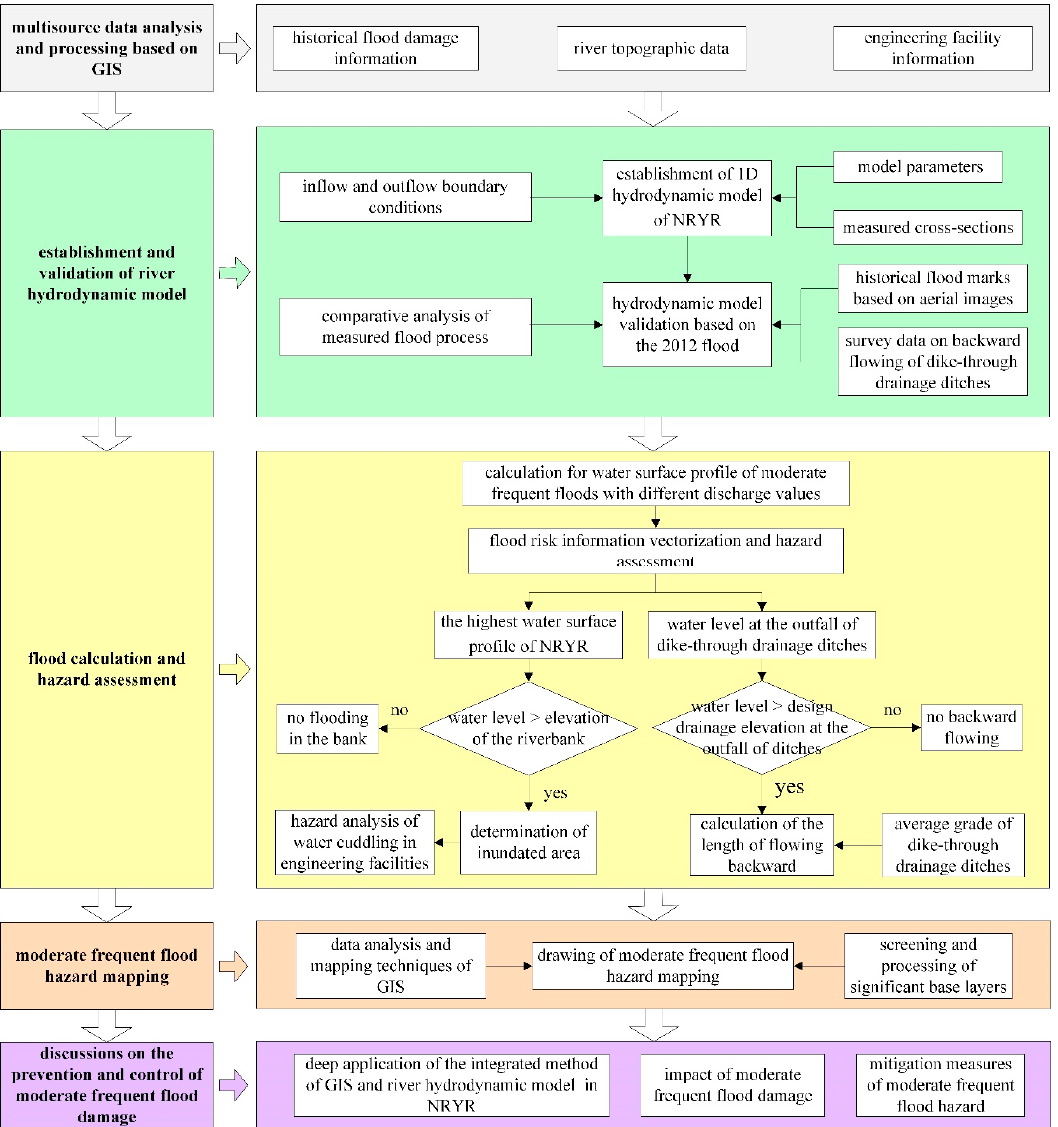
Figure 2. Technical road map for the hazard assessment of riverbank inundation due to moderate frequent flooding and backward flowing in ditches in the NRYR.